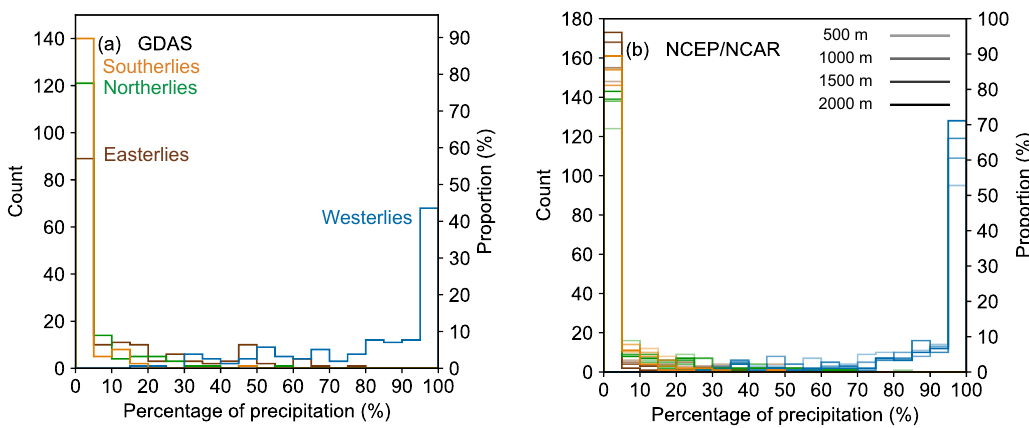
Figure A4. Histogram of monthly dE (brown), dN (green), dW (blue), and dS (orange) derived from ( a ) the GDAS and ( b ) the NCEP / NCAR reanalysis datasets with a bin size of 5%. The transparency of histogram plots in ( b ) is coded to represent results derived from di ff erent initial back-trajectory heights. The results derived from an initial back-trajectory height of 2000 m agl have zero transparency. The transparency increases (showing lighter color) with a decreasing initial back-trajectory height from 1500 m to 500 m